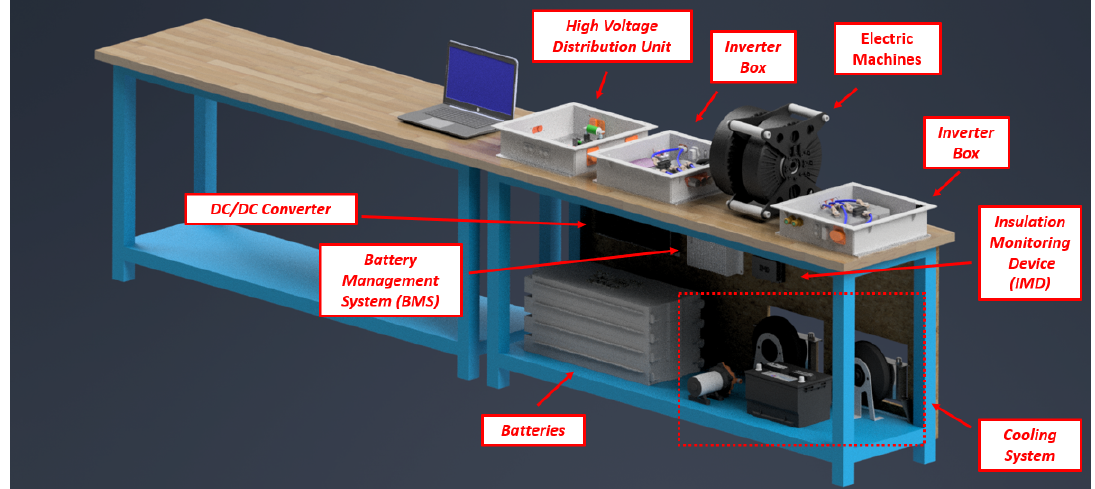
Figure 17. 3D design of the backhoe electric drive system test